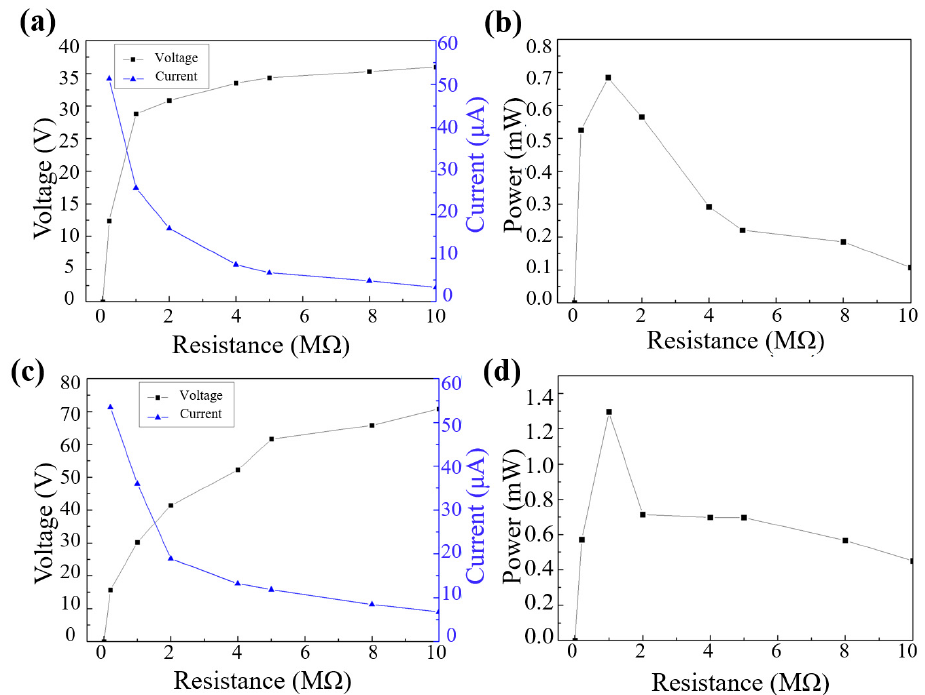
Figure 5. ( a ) Voltage–, current–resistance curve and ( b ) power–resistance curve of unstructured FTENG; ( c ) voltage–, current–resistance curve and ( d ) power–resistance curve of MN-FTENG. These four pictures show that the maximum power of MN-FTENG and FTENG appear at 1 M Ω , which are 0.68 mW and 1.296 mW.